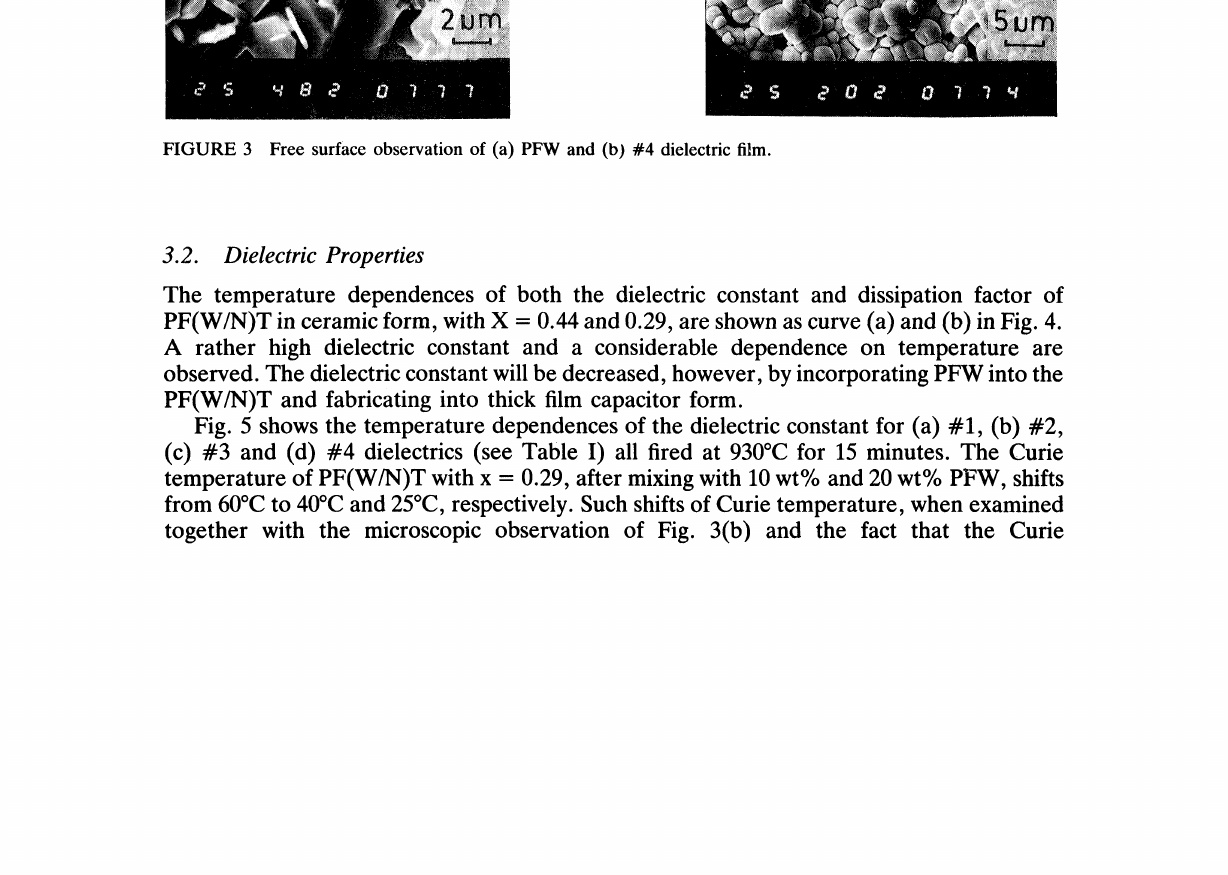
FIGURE 2 Fractured cross section observation of #1 dielectric film.